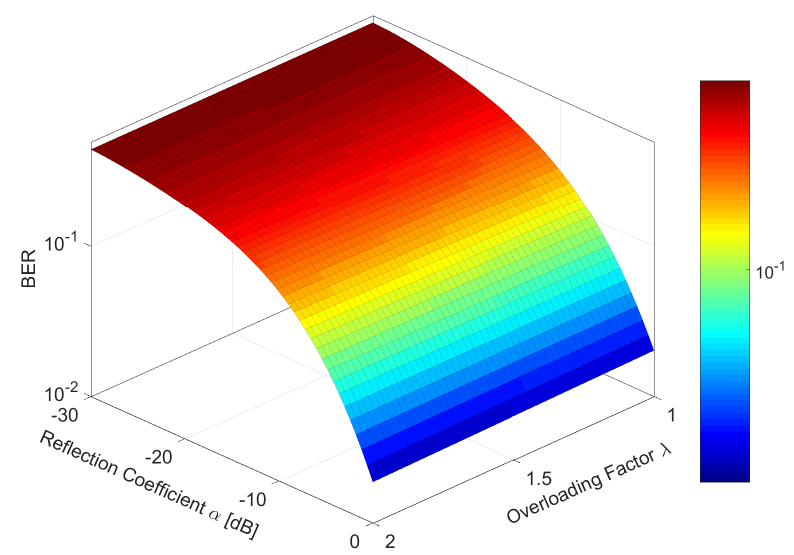
Figure 13. Effect of the overloading factor λ and the reflection coefficient α for detection performance at the reader when ζ = 0.16, D = 0.2, and M =